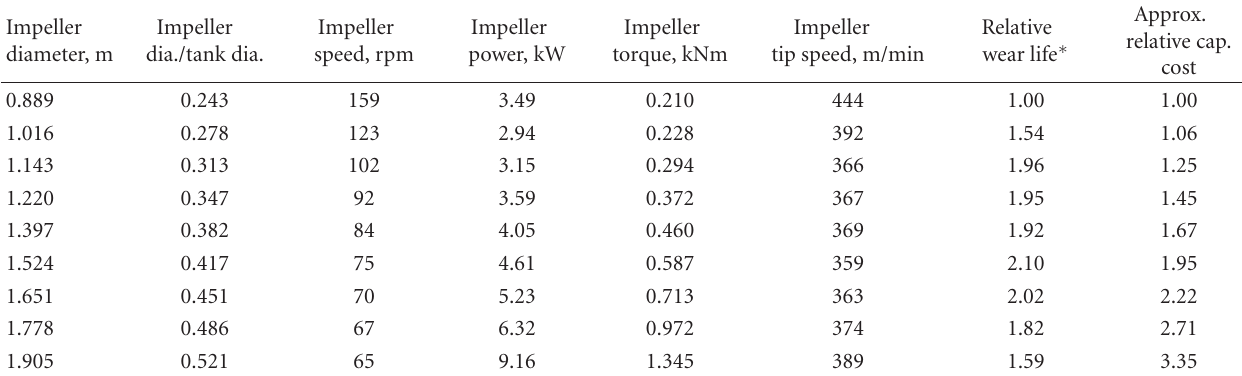
Table 2: Possible process design selections for example.